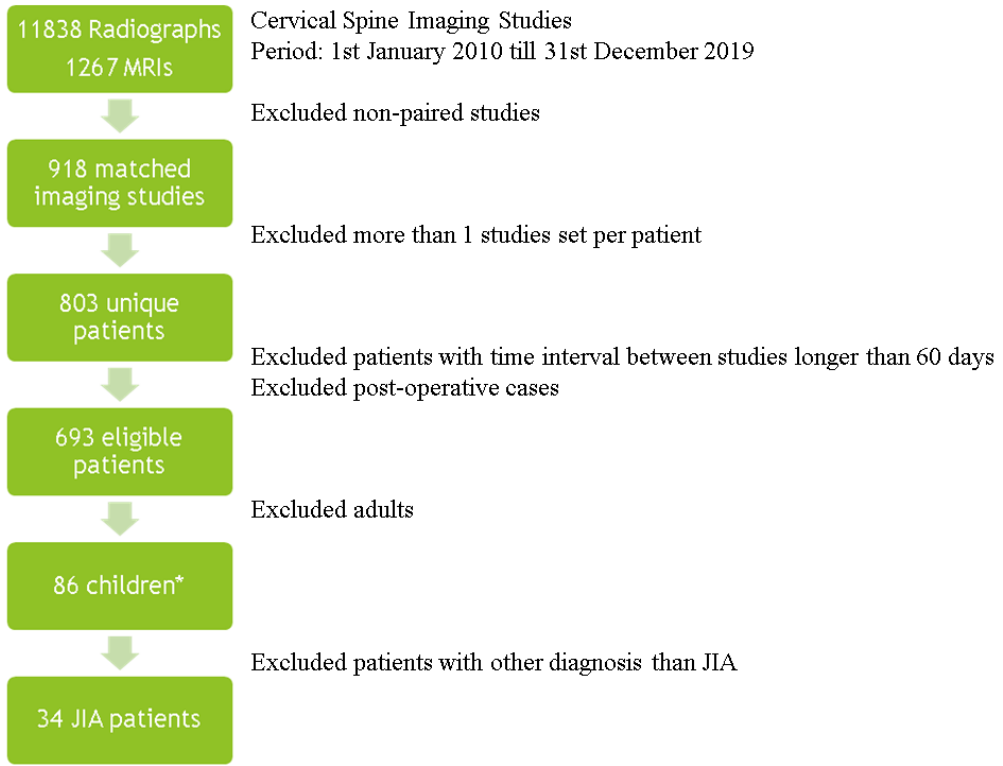
Figure 1. Summary of the inclusion process. *, 52 children with non-JIA diagnosis, after age and sex matching 38 patients, JIA—juvenile idiopathic arthritis, MRI- magnetic resonance imaging. Table 1. Comparison between JIA and non-JIA